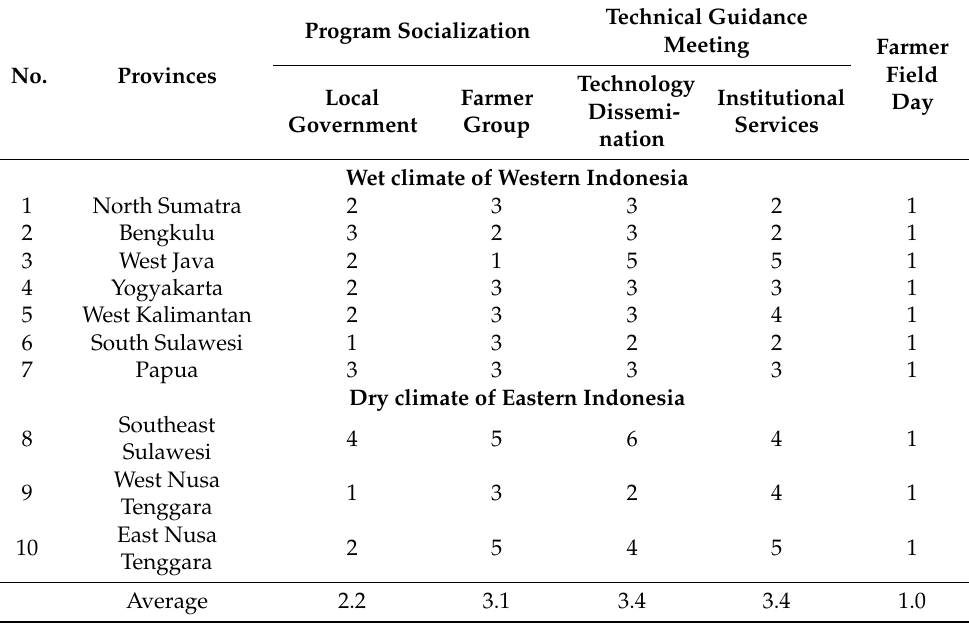
Table 2. The number of information access activities in the farmer participatory demonstration plots on rainfed lowland rice in ten provinces in Indonesia, dry season 2019.